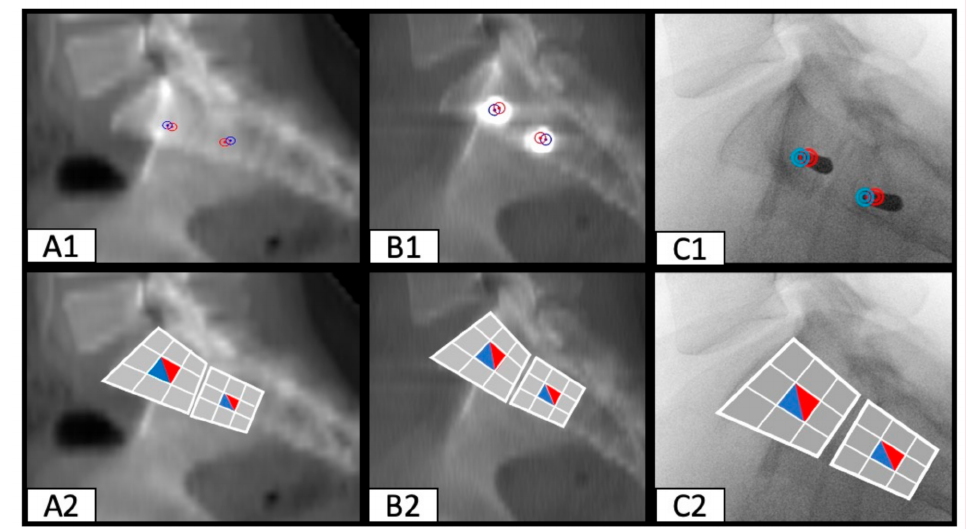
Figure 4. SI screw positioning in a patient with a straight osseous corridor (entry- and endpoint are close together). Predicted entry- (red circle) and endpoint (blue circle) of the perfect osseous corridor preoperatively ( A1 ). Actual entry- (red circle) and endpoint (blue circle) of the inserted SI screw ( B1 ). Intraoperative fluoroscopy image with an inserted k-wire, the red circle shows the entry point at the lateral iliac corticalis, the blue circle the tip of the k-wire ( C1 ). Visualization of the predicted ( A2 ), actual ( B2 ), and intraoperative ( C2 ) entry- and endpoints of the SI screws using the nine segment division of S1 and S2 vertebral bodies.